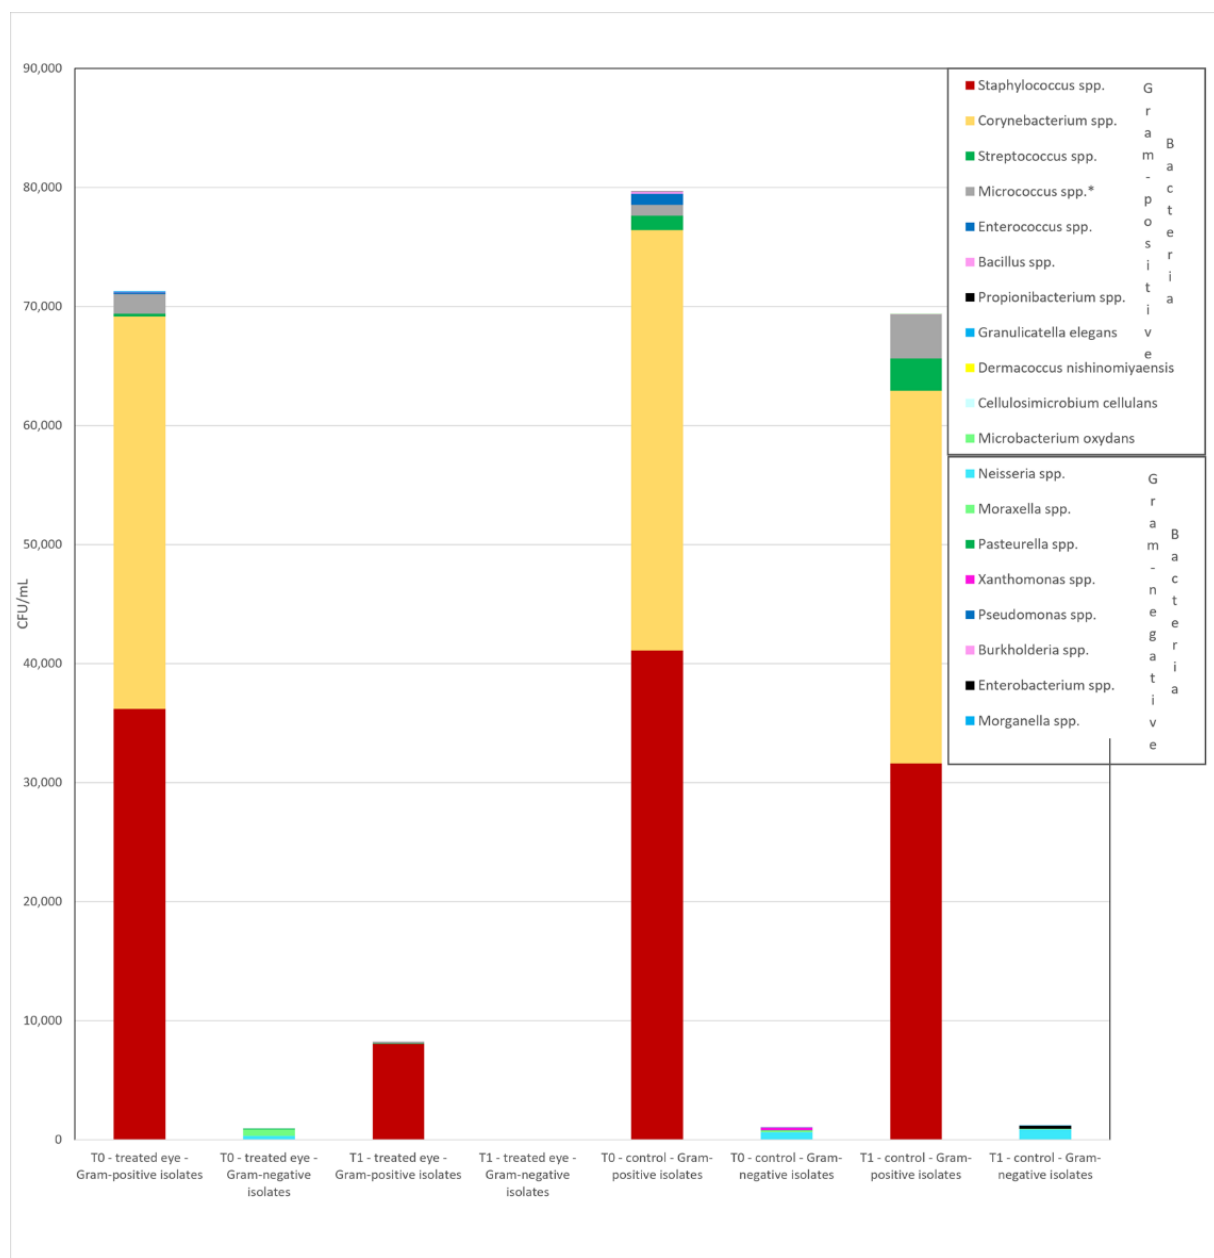
Figure 1. Distribution of Gram-positive and Gram-negative cumulative loads between the treated–untreated eyes at the T 0 and T 1 points. spp. = different species; * including Kocuria and Rothia spp.